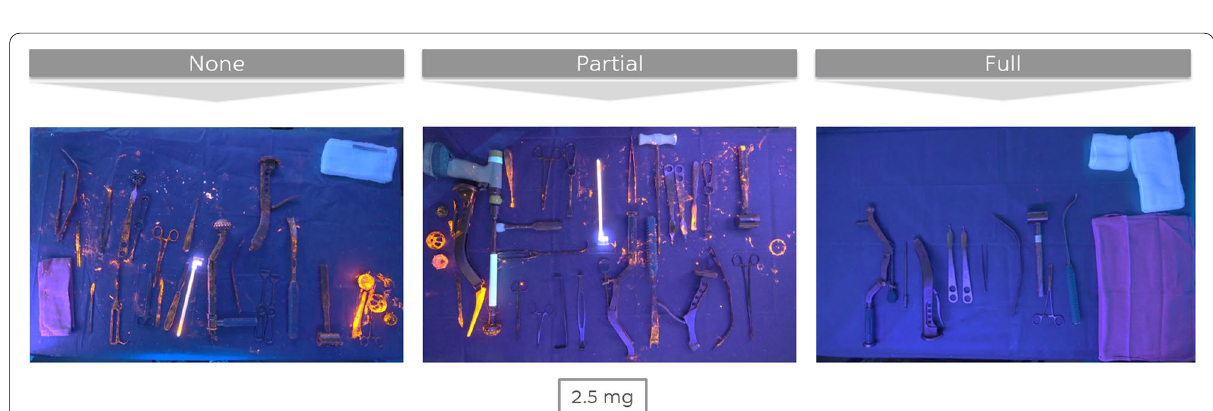
Fig. 4 Gloves of the surgical team at the end of the one-step exchange for three different clean phase protocols (bacterial load of 3 GloGerm powder)